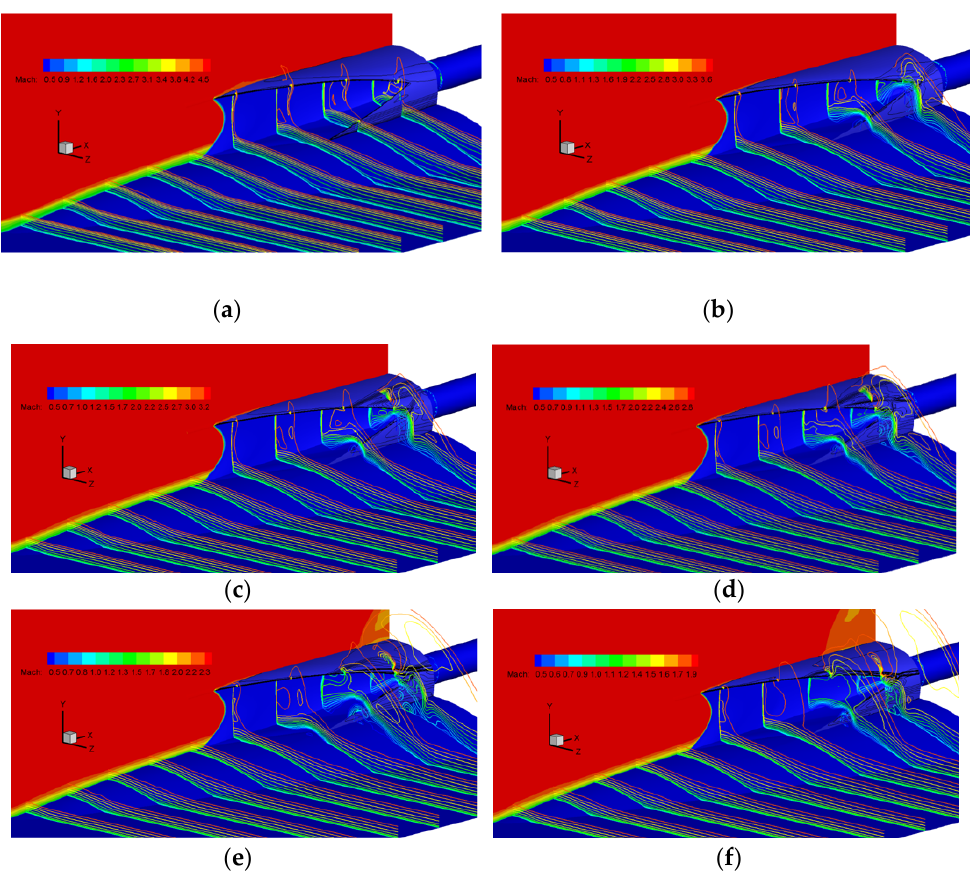
Figure 15. Incident shock system at low speed conditions ( L BL = 3.5 m). ( a ) M ∞ = 5.0; ( b ) M ∞ = 4.0; ( c ) M ∞ = 3.5; ( d ) M ∞ = 3.0; ( e ) M ∞ = 2.5; ( f ) M ∞ = 2.0.